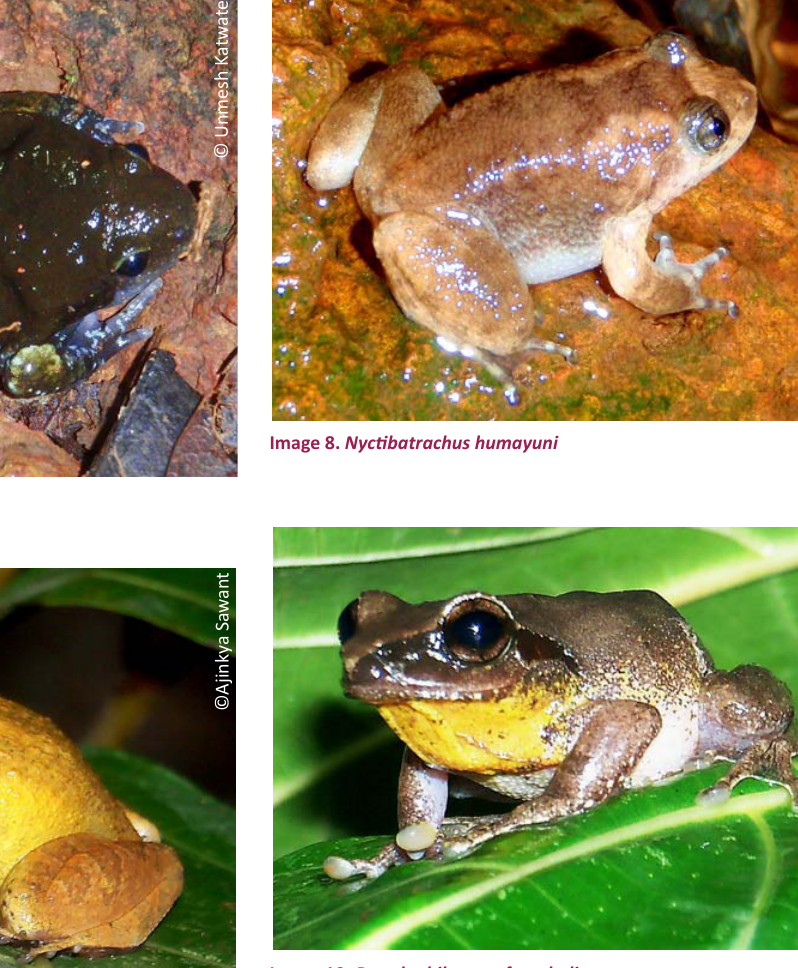
Image 10. Pseudophilautus cf. amboli